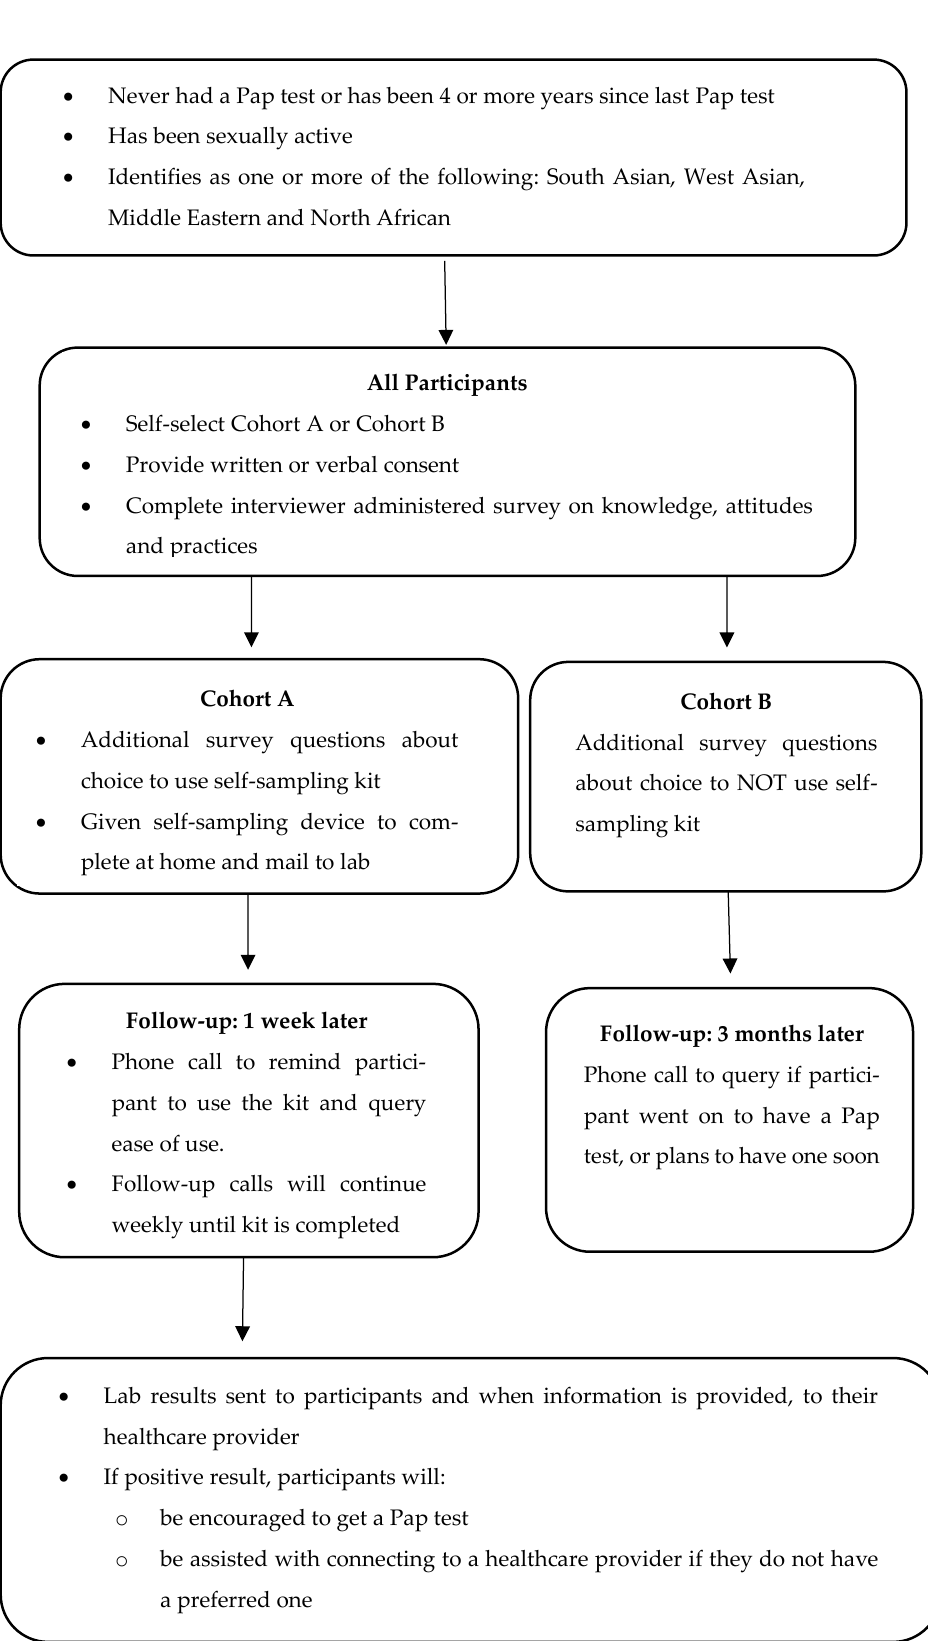
Figure 1. Recruitment and participation for Cohort A and Cohort B.